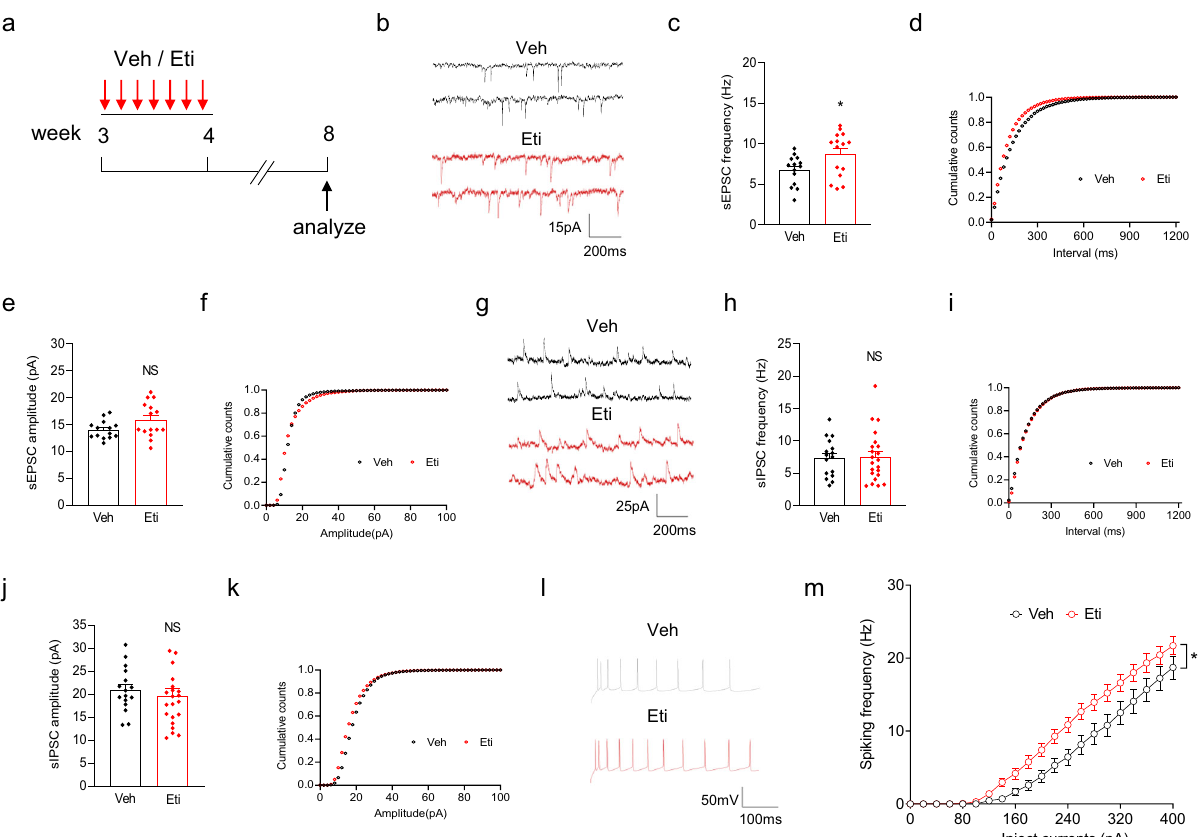
Fig. 8 Hyperglutamatergic function of Drd2-positive neurons after inhibition of DRD2 during adolescence. a Experimental design. SR-Drd2 rats received daily injection of Eti (1 μ g in 0.5 μ l per side) or Veh (0.5 μ l saline per side) into layer 5 of ACC between 3- and 4-week-old age, the sEPSC, sIPSC, and cell excitability of Drd2-positive neurons were then analyzed at 8-week-old age. b Representative sEPSC traces of Drd2-positive neurons from 8-week-old Eti and Veh-treated rats. c Increased sEPSC frequency of Drd2-positive neurons in Eti-treated SR-Drd2 rats, compared with controls. * P = 0.0324, two-sided t - test, n = 14 neurons from 3 control rats, n = 15 neurons from 3 Eti-treated rats. Data are presented as mean values ± SEM. d Cumulative plots of sEPSC frequency. e Similar sEPSC amplitude of Drd2-positive neurons between Veh and Eti- treated rats. NS not signi fi cant, P = 0.0672, two-sided t -test, n = 14 neurons from 3 control rats, n = 15 neurons from 3 Eti-treated rats. Data are presented as mean values ± SEM. f Cumulative plots of sEPSC amplitude. g Representative sIPSC traces of Drd2-positive neurons from 8-week-old Veh and Eti-treated rats. h Similar sIPSC frequency of Drd2-positive neurons between Veh and Eti-treated rats. NS not signi fi cant, P = 0.9176, two-sided t -test, n = 16 neurons from 3 control rats, n = 22 neurons from 3 Eti-treated rats. Data are presented as mean values ± SEM. i Cumulative plots of sIPSC frequency. j Similar sIPSC amplitude of Drd2-positive neurons between Veh and Eti-treated rats. NS not signi fi cant, P = 0.5628, two-sided t -test, n = 16 neurons from 3 control rats, n = 22 neurons from 3 Eti-treated rats. Data are presented as mean values ± SEM. k Cumulative plots of sIPSC amplitude. l Representative action potentials of Drd2-positive neurons from 8-week-old Veh and Eti-treated rats. m Increased excitability of Drd2-positive neurons in Eti-treated rats, compared with controls. Shown are the I/O curves of action potentials from Drd2-positive neurons. * Genotype F (1, 62) = 5.933, P = 0.0177, two-way ANOVA, n = 31 neurons from 4 control rats, n = 33 neurons from 4 Eti-treated rats. Data are presented as mean values ± Elevated O-maze . The elevated O-maze is an annular platform with a width of 5.5cm and an outer diameter of 92 cm. The elevated maze has two open parts and 50cm above the fl oor. During the test, the rats were placed into one of the open parts facing the closed part, and were allowed to freely explore the maze for 10 min. The behavior of each rat was recorded by a digital camera and was analyzed using the Any-maze system (Stoelting). The maze was wiped clean with 75% ethanol after each session.